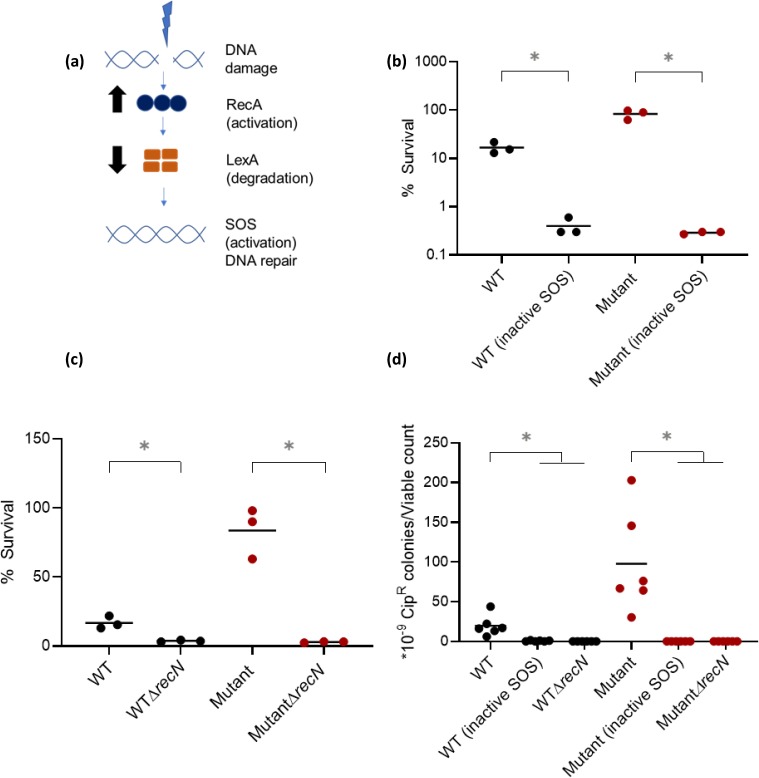
Mistranslation increases early survival and ciprofloxacin resistance via the SOS response.(a) Schematic of the SOS response in E.coli (b-c) Early survival of indicated strains inoculated from single colonies (n = 3), treated with 50 ng/mL Cip for 2h, and then plated on plain LB. Plots show the mean % survival calculated from total viable counts before and after Cip treatment. (b) Effect of inactivating the SOS response using the lexA3 allele. Unpaired t test, WTlexA3 or WT(inactive SOS)<WT, t = 6.2, P = 0.02; MutantlexA3 or Mutant(inactive SOS)<Mutant, t = 7.8, P = 0.02; WT (inactive SOS) vs Mutant (inactive SOS), ns, t = 0.96, P = 0.43 (c) Effect of inhibiting recombination, tested by knocking out the recN gene. Unpaired t test, WΔrecN <WT, t = 4.9, P = 0.03; MutantΔrecN<Mutant, t = 7.6, P = 0.02; WTΔrecN vs MutantΔrecN, ns, t = 0.96, P = 0.43 (d) Resistance of cultures inoculated from single colonies (n = 6) of indicated strains, pulsed with 20 ng/mL ciprofloxacin (Cip-20) for 1 h, and plated on LB agar with vs. without 50 ng/mL Cip (Cip-50). The plot shows the mean proportion of resistant colonies relative to total viable counts. Mann-Whitney U test: Mutant>WT, U = 1, P = 0.0043; WT(inactive SOS)<WT, U = 0, P = 0.0022; Mutant(inactive SOS)<Mutant, U = 0, P = 0.0022; WTΔrecN<WT, U = 0, P = 0.0022; MutantΔrecN<Mutant, U = 0, P = 0.0022.